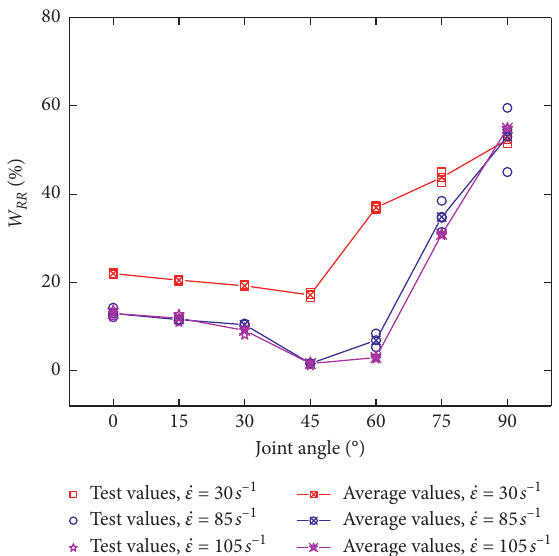
Figure 10: The variable tendency of W three different strain rates.